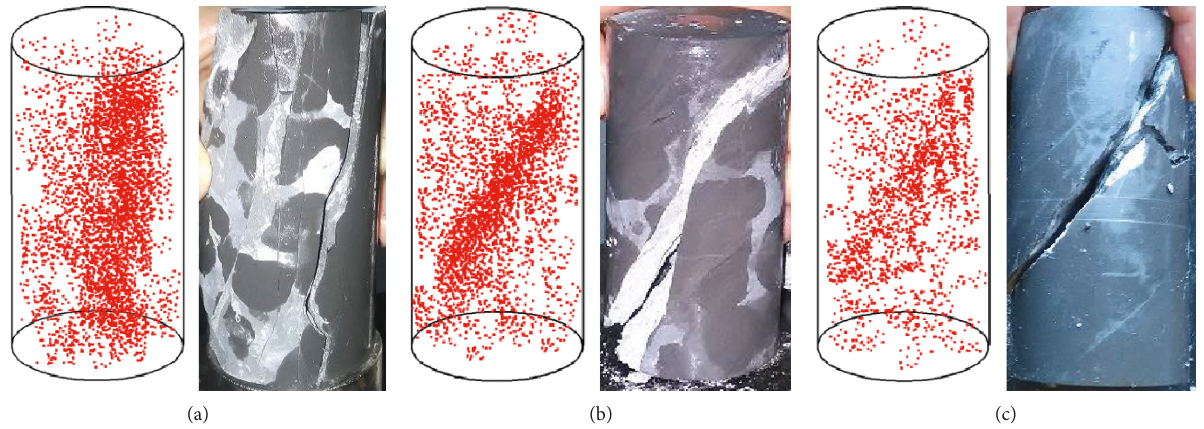
Figure 12: AE location results and failure pictures of dry samples at the moment of rock failure under different confining pressures. (a) 0MPa. (b) 15MPa. (c)